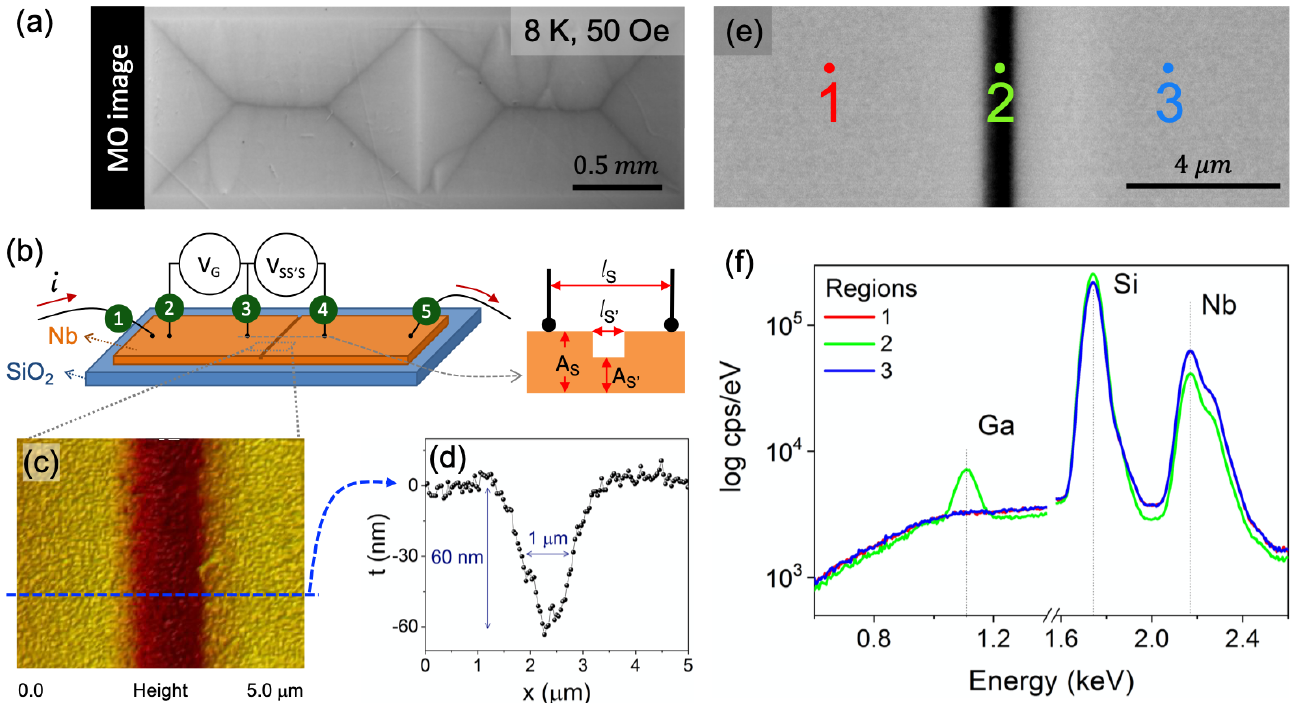
Figure 1. (Color online) ( a ) Magneto-optical (MO) image of the grooved Nb film taken at 8 K and 50 Oe after a ZFC procedure. ( b ) Schematic representation of the sample and details of the contact leads used in transport measurements. ( c ) AFM image and ( d ) profile for the SS’S region. ( e ) SEM image and the identification of three different points at which the EDS spectra were taken. ( f ) EDS spectra showing the K α line for gallium, which appears only in the region inside the groove